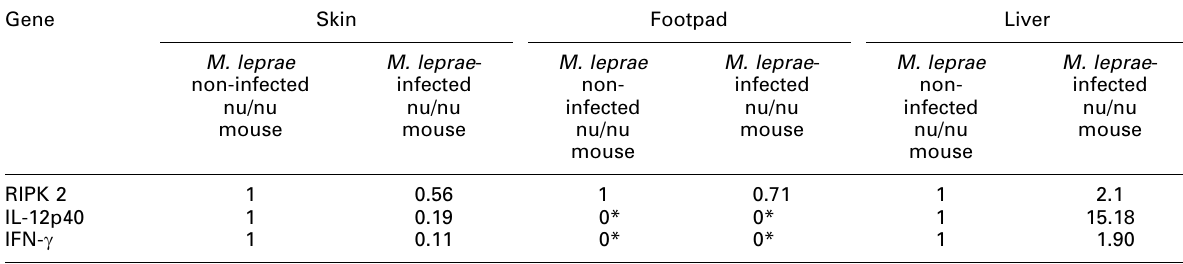
Table 1. RIPK 2 and inflammatory cytokine mRNA expression